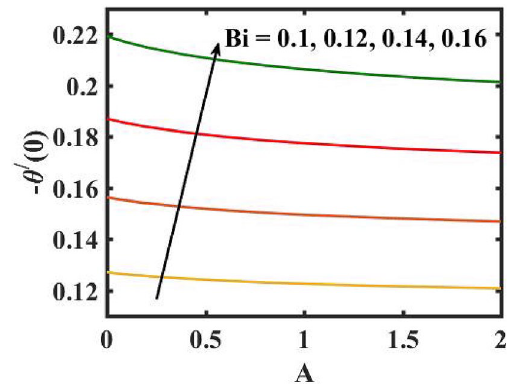
Figure 21. Encouragement of Bi and A local Nusselt number.